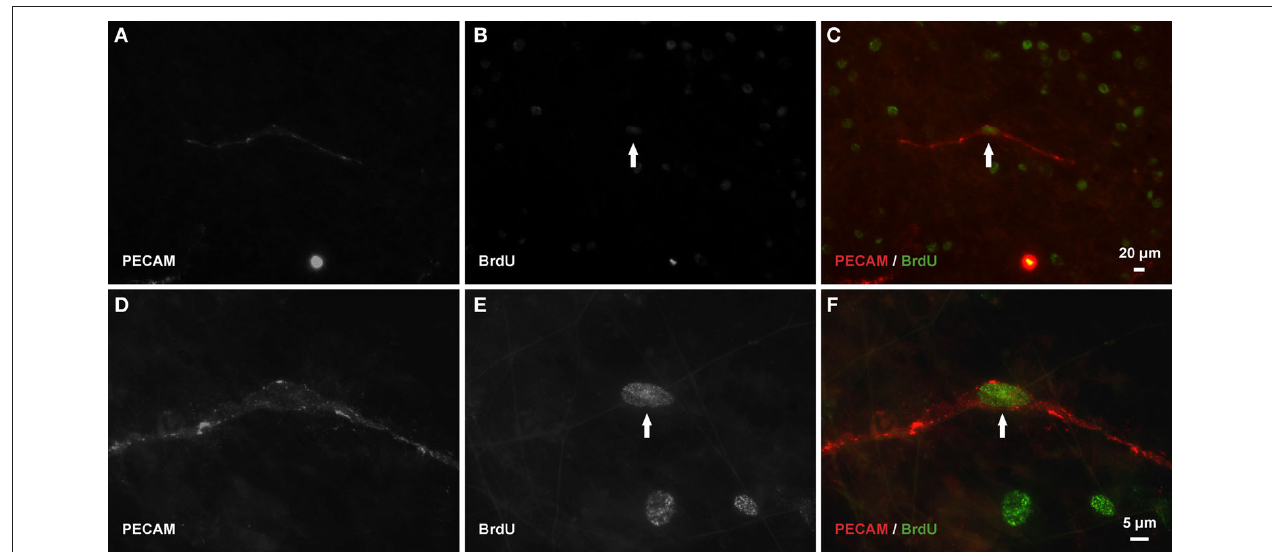
FIGURE 8 | Endothelial cells along vascular islands undergo proliferation during angiogenesis post restimulation. (A–C) Example BrdU-positive nucleus (arrow) along a PECAM positive vascular island. (D–F) Higher magnification images of PECAM and BrdU labeling of the same vascular